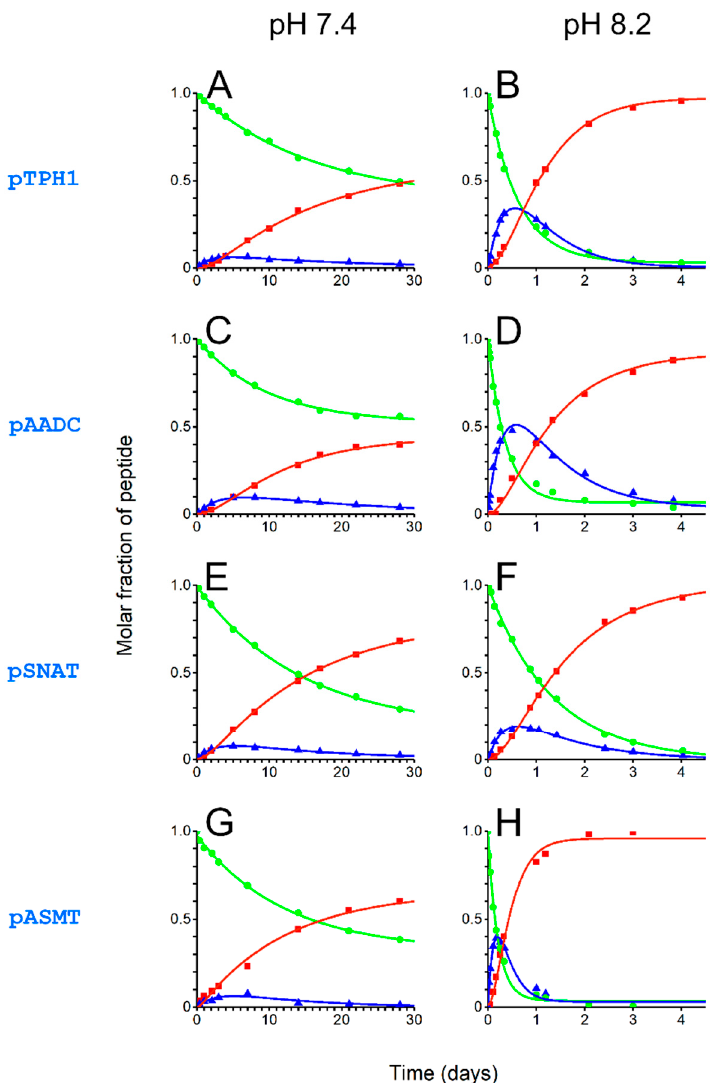
Figure 6. Ni(II)-assisted peptide bond hydrolysis in pTPH1 ( A , B ), pAADC ( C , D ), pSNAT ( E , F ), and pASMT ( G , H ) at pH 7.4 (left) and 8.2 (right), 37 °C. The traces show intact substrate peptides (green, dots), intermediate products (blue, triangles), and cleaved products (red, squares).